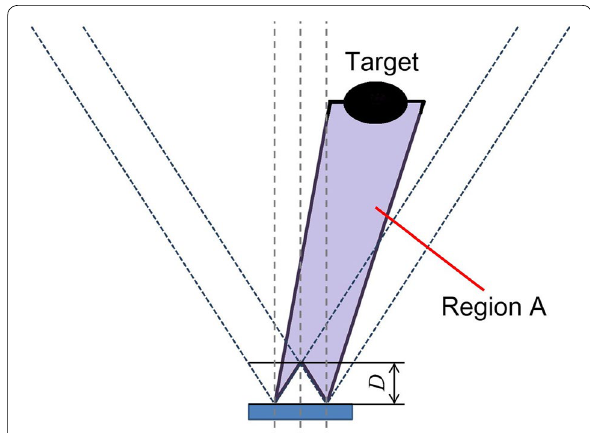
Fig. 7 Definition of Region A. The blue rectangle shows a stereo camera, and the dotted lines indicate the cameras’ fields of view. D is the closest distance that can be measured by the stereo camera. Region A is defined as the inner region, which is structured by lines that connect the left camera with the left edge and the right camera with the right edge of a target’s region with margins